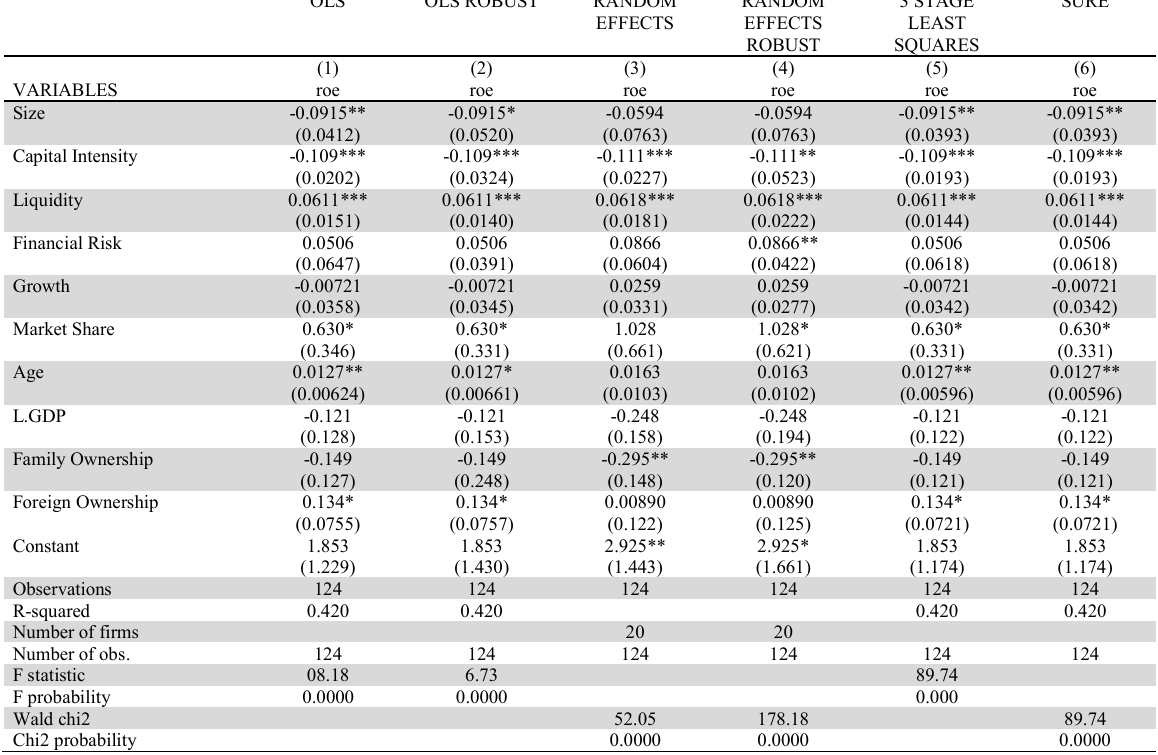
The results of Regression 2